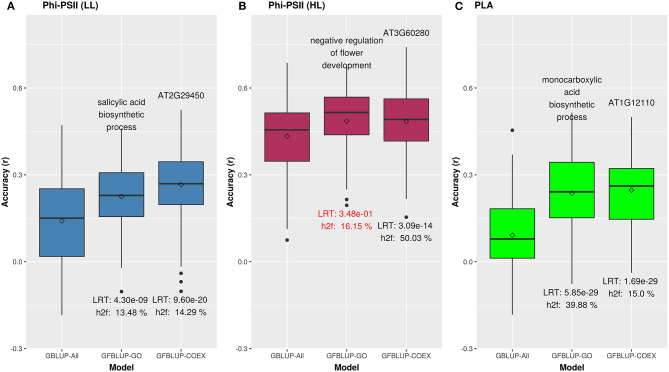
Biological priors can help improve genomic prediction accuracy for growth related traits. Prediction accuracy of the best overall GFBLUP models using Gene Ontology (GO) and co-expression (COEX) gene groups, compared to the GBLUP benchmark (without prior biological knowledge). Since the GBLUP model was evaluated for each measurement point, so the GBLUP here is shown for the corresponding time point where improvement by GFBLUP was observed. Accuracy was calculated as Pearson's r between true vs. predicted values. The GBLUP-ALL model uses all markers in GBLUP; GFBLUP-GO and GFBLUP-COEX models use the top GO terms and COEX (see text for details). (A) Accuracy for ΦPSII under low light irradiance levels (LL). (B) Accuracy for φPSII under high light irradiance (HL). Here, despite showing some improvement, the GFBLUP-GO model did not pass all of our model evaluation criteria (see Model Performance Evaluation). (C) Accuracy for PLA.